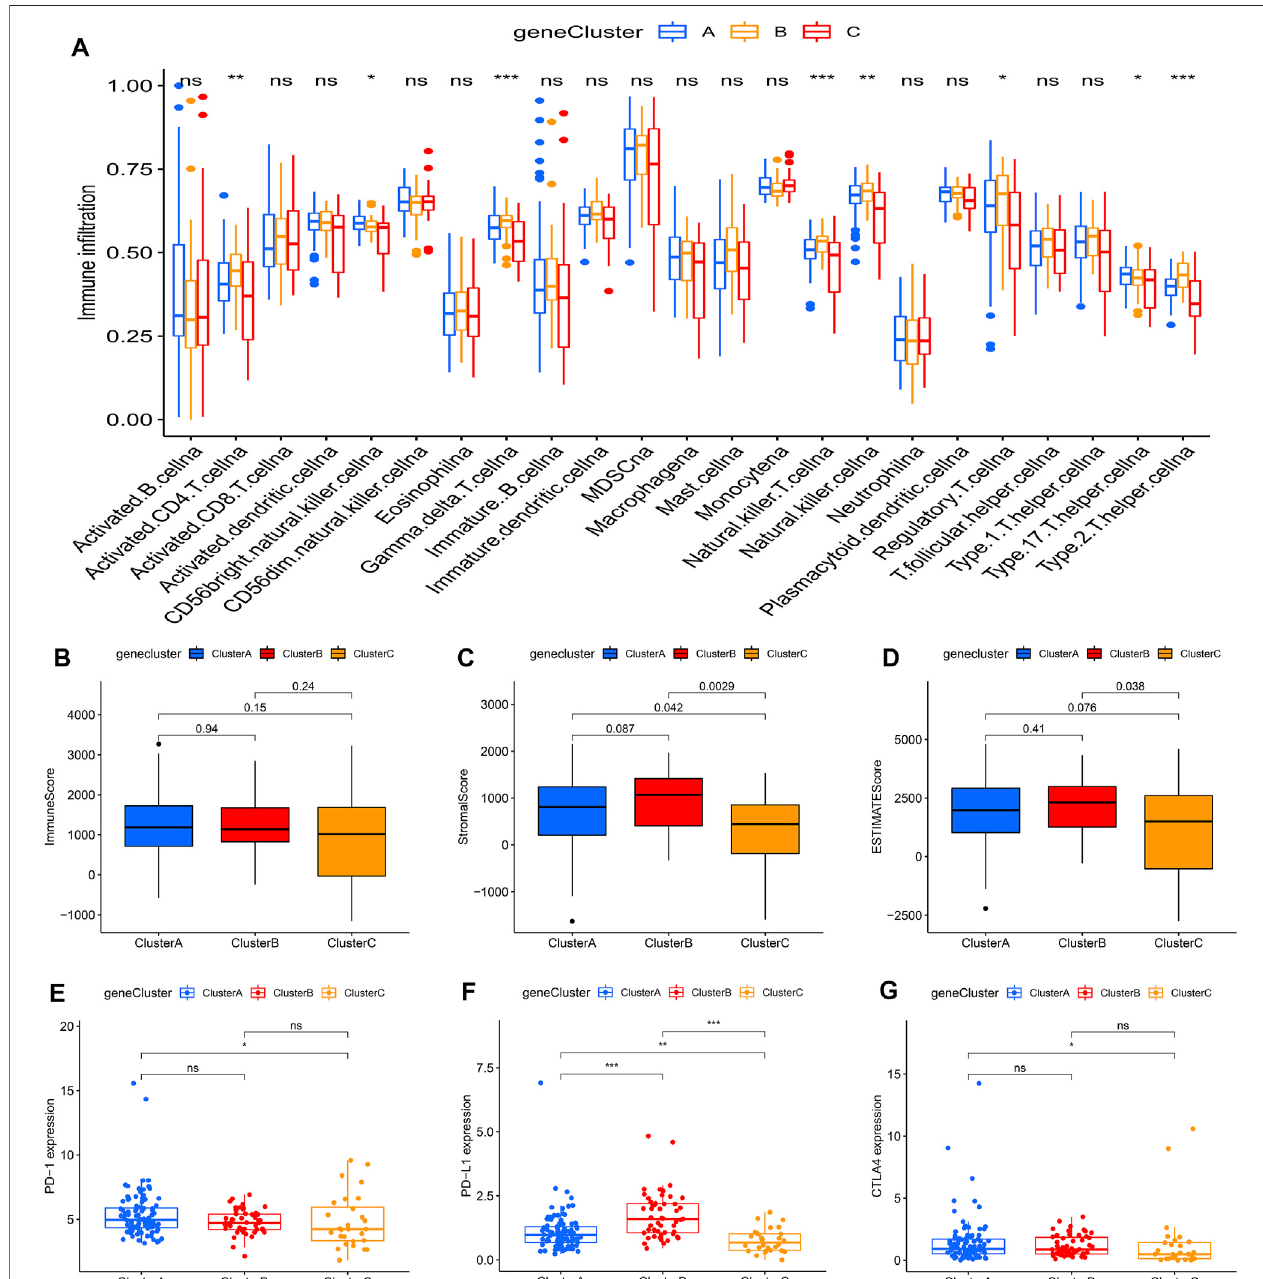
FIGURE 6 | Tumor immune landscapes in distinct gene clusters. (A) ssGSEA of patients in distinct gene clusters, the asterisks represented the statistical p value (* p < 0.05; ** p < 0.01; *** p < 0.001); (B) Immune scoreofpatients indistinct geneclusters; (C) Stromal scoreofpatientsindistinctgeneclusters; (D) ESTIMATEscoreof patientsindistinct geneclusters; (E) PD-1expression ofpatients indistinctgeneclusters(* p < 0.05; ** p < 0.01;*** p < 0.001); (F) PD-L1 expressionofpatientsindistinct gene clusters (* p < 0.05; ** p < 0.01; *** p < 0.001); (G) CTLA4 expression of patients in distinct gene clusters (* p < 0.05; ** p < 0.01; *** p < 0.001).